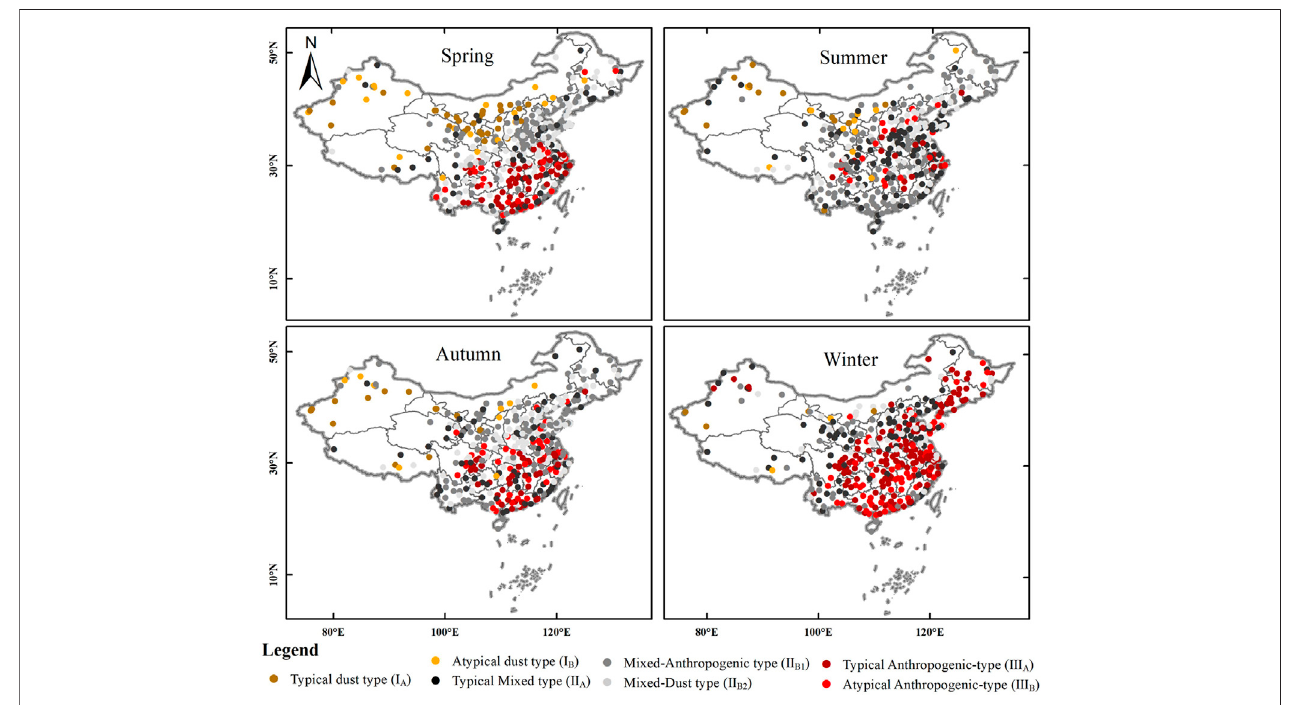
FIGURE 10 | The spatial distribution of urban pollution classi fi cation results based on the ratio of PM 2.5 /PM 10 in the four seasons.